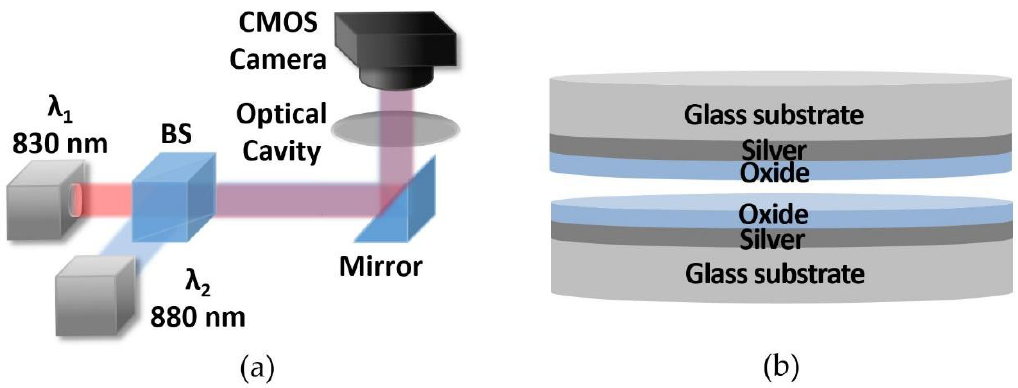
Figure 1. ( a ) Schematic diagram of the optical cavity-based sensor using 830 nm and 880 nm laser diodes. ( b ) Cross-sectional view of the optical cavity structure.